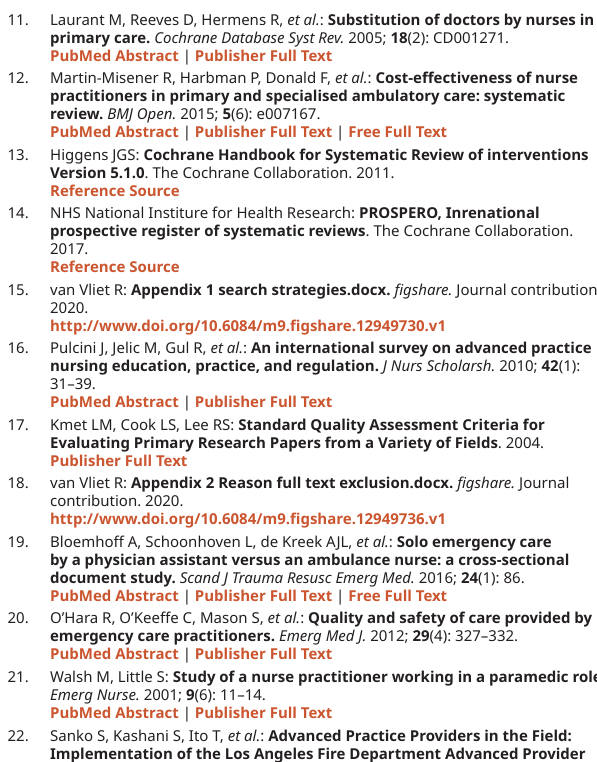
Figshare: Appendix 2 Reason full text exclusion.docx.